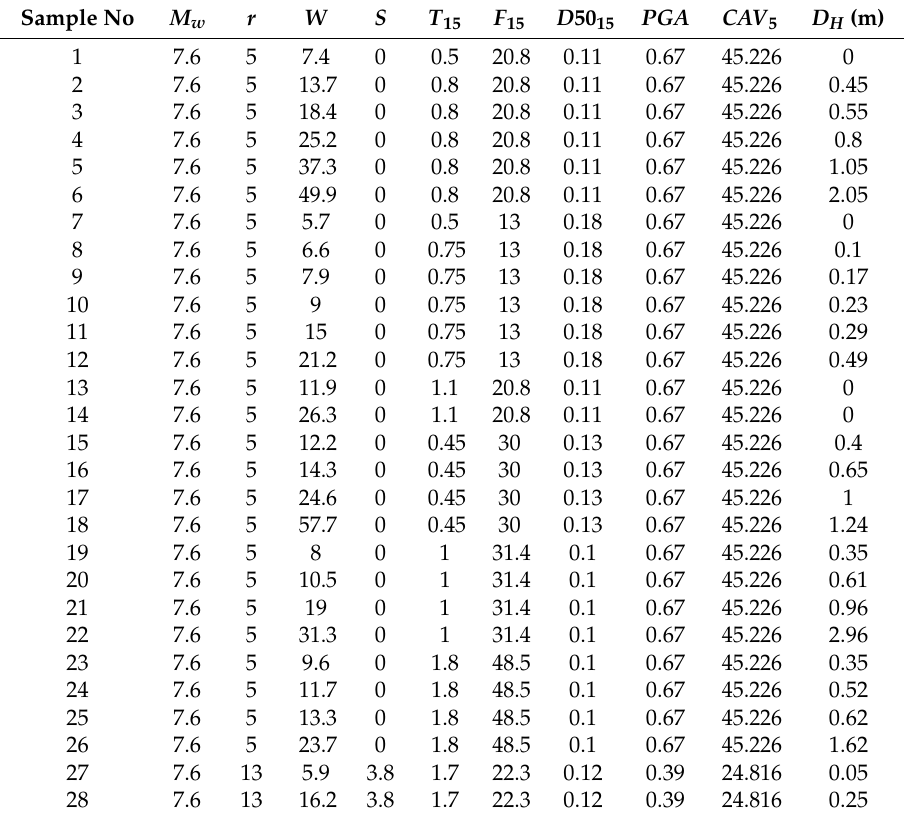
Table 7. Model parameters and measured D H at sites affected by the 1999 Chi-Chi